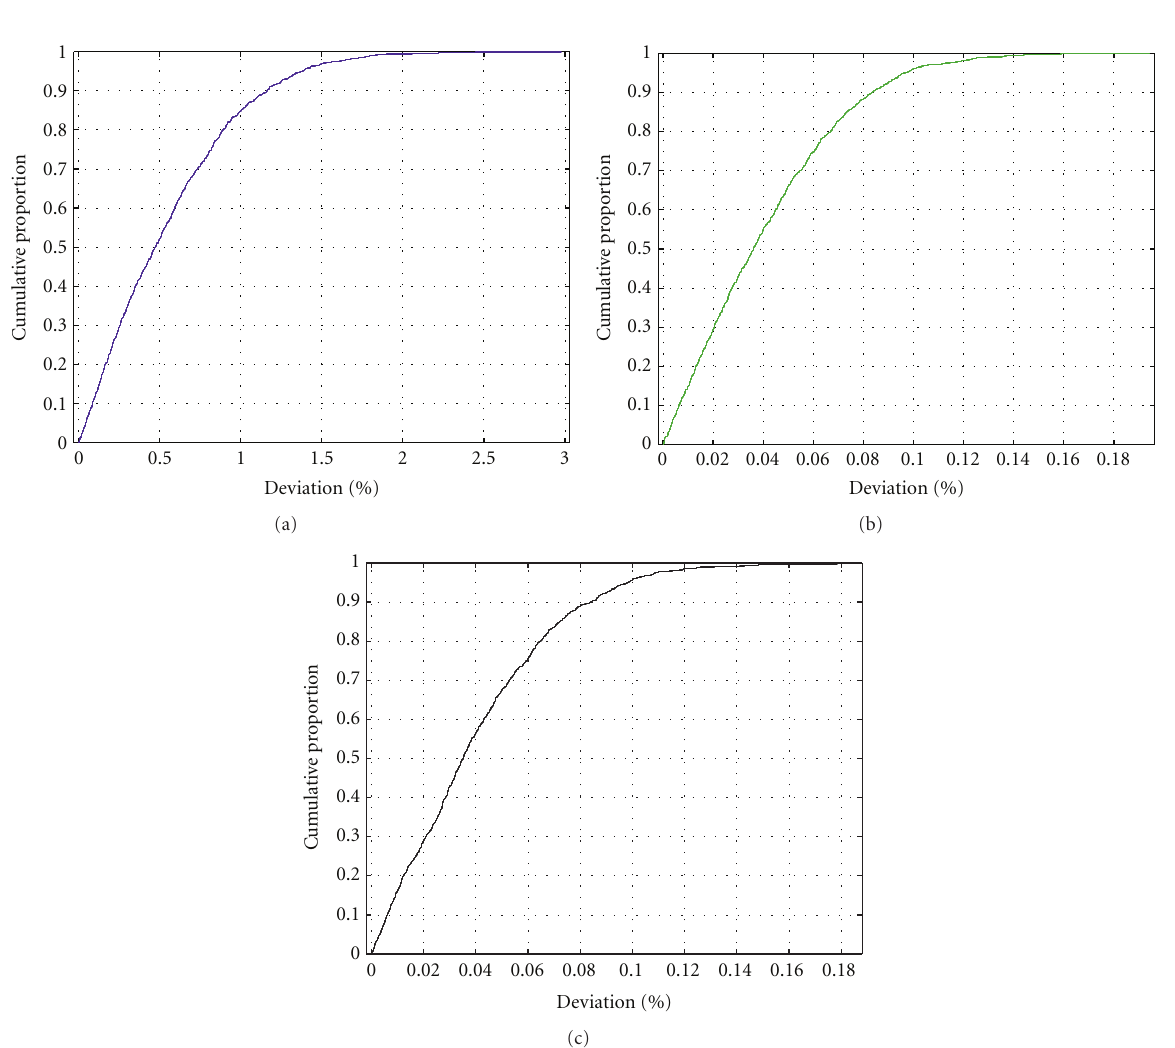
Figure 3: (a) Cumulative proportion curve of the D deviations. (b) Cumulative proportion curve of the Q deviations. (c) Cumulative proportion curve of the Z deviations, for 1,000